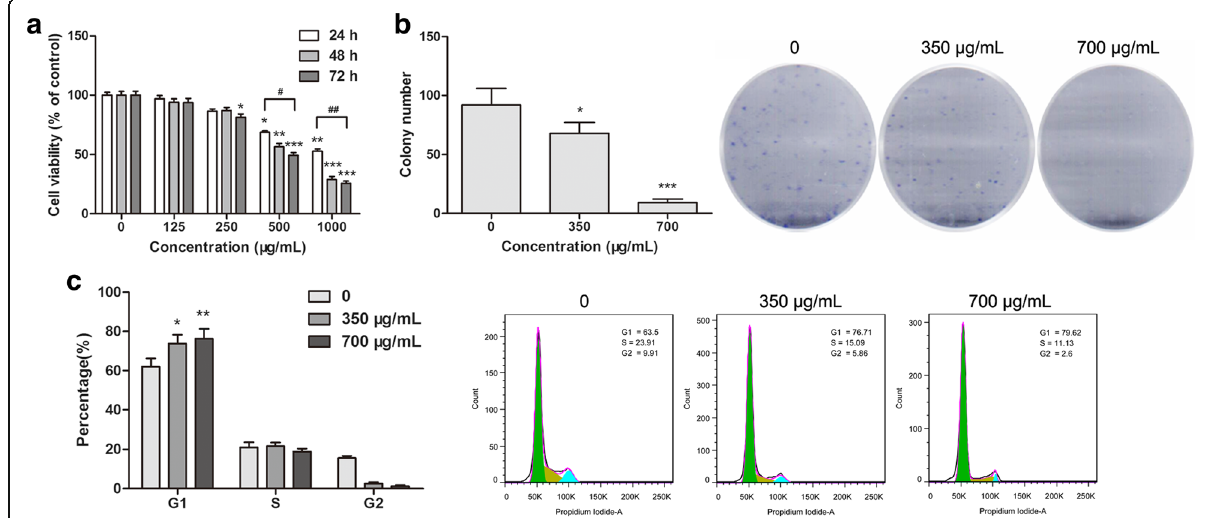
Fig. 1 Jinfukang inhibits CTC-TJH-01 cell growth. a CTC-TJH-01 cells were incubated with Jinfukang (0, 125, 250, 500, and 1000 μ g/mL) for 24 h, 48 h and 72 h. The CCK-8 assay was performed to determine the cytotoxic effect of Jinfukang. b Representative images of the colony formation assay. c CTC-TJH-01 cells were treated with Jinfukang (0, 350, and 700 μ g/mL) for 48 h. Flow cytometry was performed to determine the cell cycle. Each bar represents the means±SD of three separate experiments. * P < 0.05; ** P < 0.01; *** P <